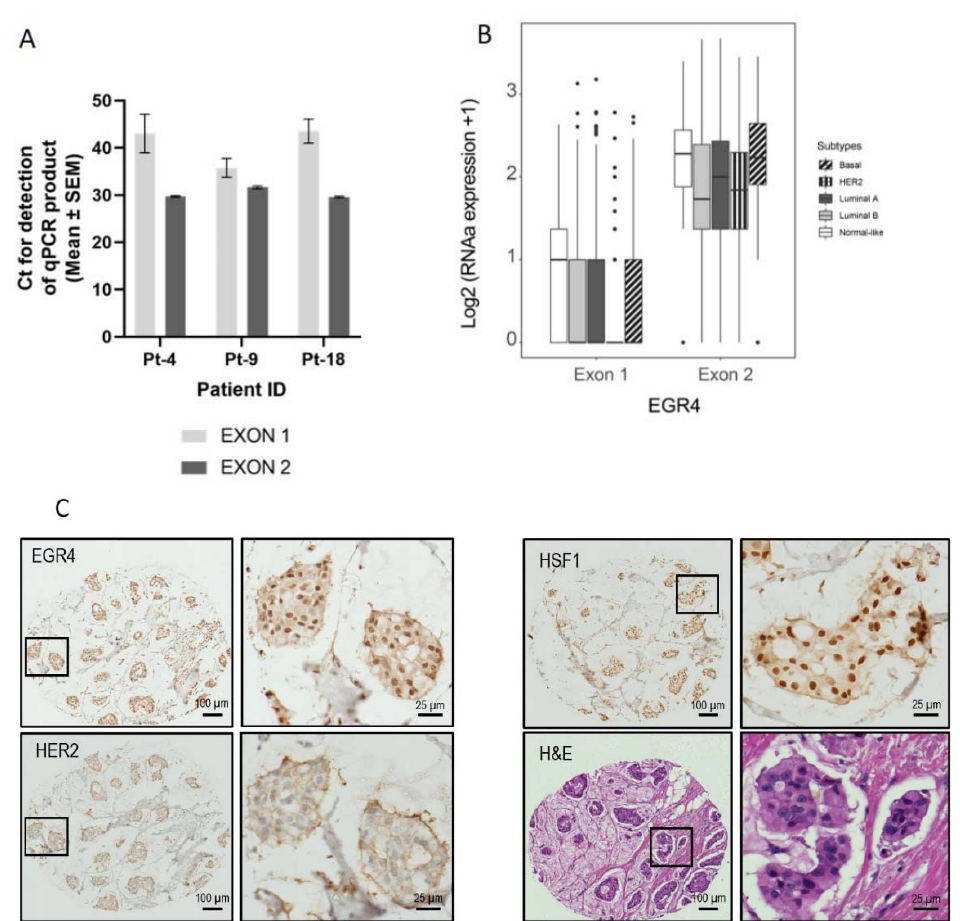
Figure 3. Confirmation of the EGR4-S splice variant in cell lines and clinical samples. ( A ) Results from qPCR on three breast tumour patient biopsies showing the amplification cycle for a qPCR product (mean ± SEM) detected using primers binding in exon 1 vs. primers binding in exon 2 for the same tumour sample. ( B ) Analysis of TCGA BRCA RNA-seq dataset ( n = 1085) showing distribution and median proportional change for the expression of EGR4 exon 1 and exon 2 mRNA in patients diagnosed with breast carcinoma ( n = 1085). Expression of mRNA is separated according to breast cancer sub-type. ( C ) Representative punch biopsies from a HER2+ breast tumour at low magnification (left panels) and high magnification (right panels).